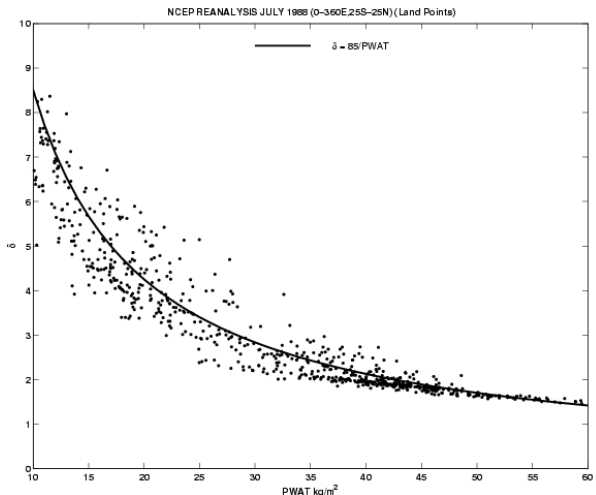
Fig. 1. Variation of the stability parameter δ with integrated water vapour in July 1988 based on data from NCEP reanalyses (Kalnay et al., 1996). Solid line corresponds to the curve δ = 85 /P w